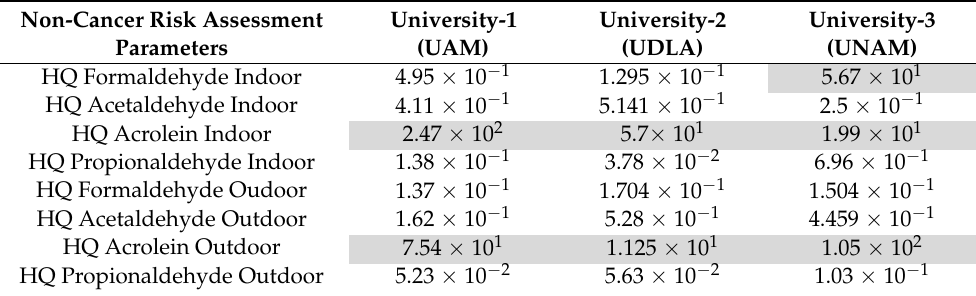
Table 10. Average non-cancer risk coefficients estimated as Hazard Quotients (HQ) for the measured carbonyls in the three sampling